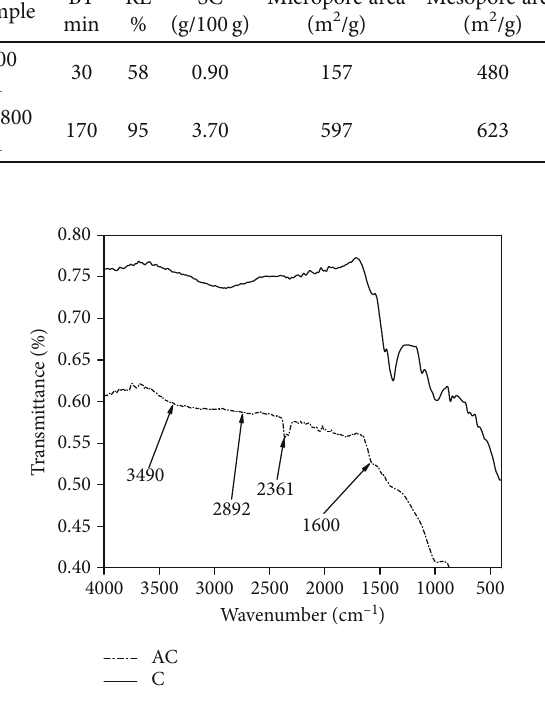
Figure 3: FTIR spectrum of carbonized and activated